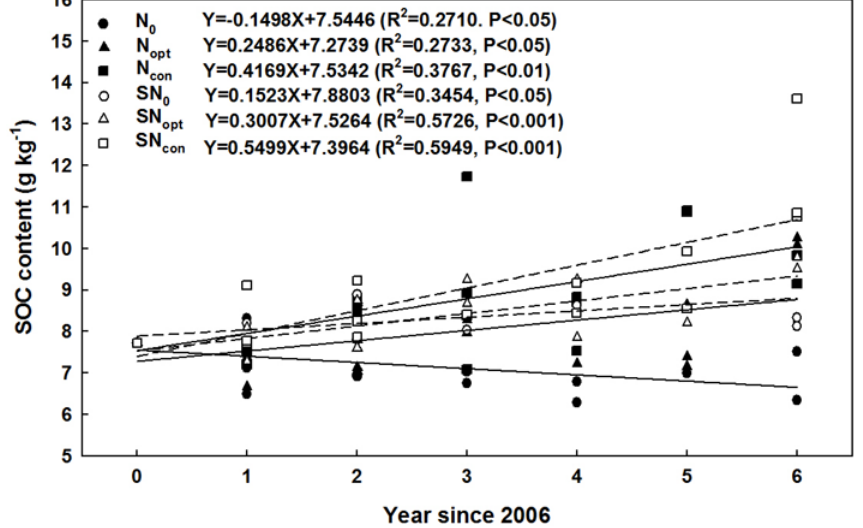
Fig. 2. Changes in soil organic carbon (SOC) in the top 20cm of the soil profile in the winter wheat–summer maize double-cropping system from 2006 to 2012. The dashed line and solid line were fitted by linear regression from straw and without straw treatments, respectively.